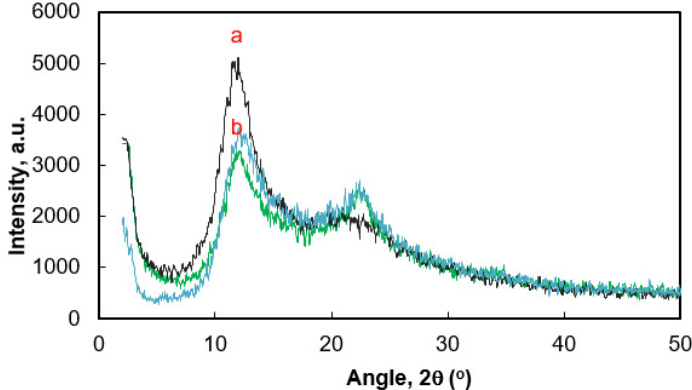
Figure 12. X-ray diffractograms: ( a ) PDMS, ( b ) PDMS composite with 10 wt.% of CF; ( c ) and PDMS composite with 10 wt.% of CFvap.